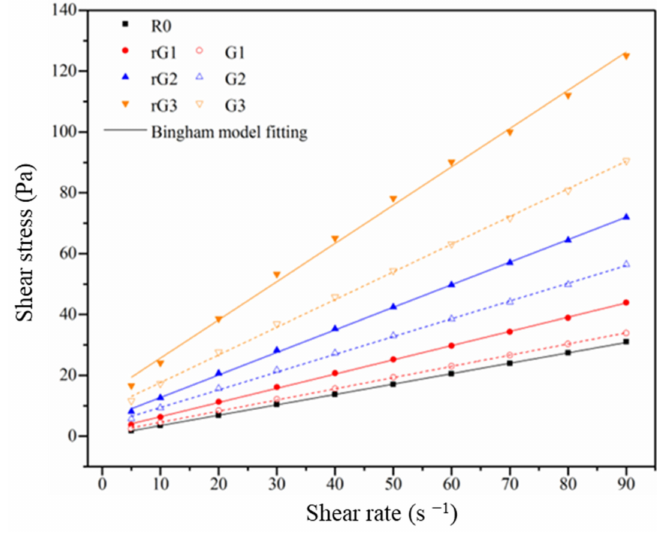
Figure 8. Flow curves of the samples. Table 4. Parameters of fitting curves using the Bingham